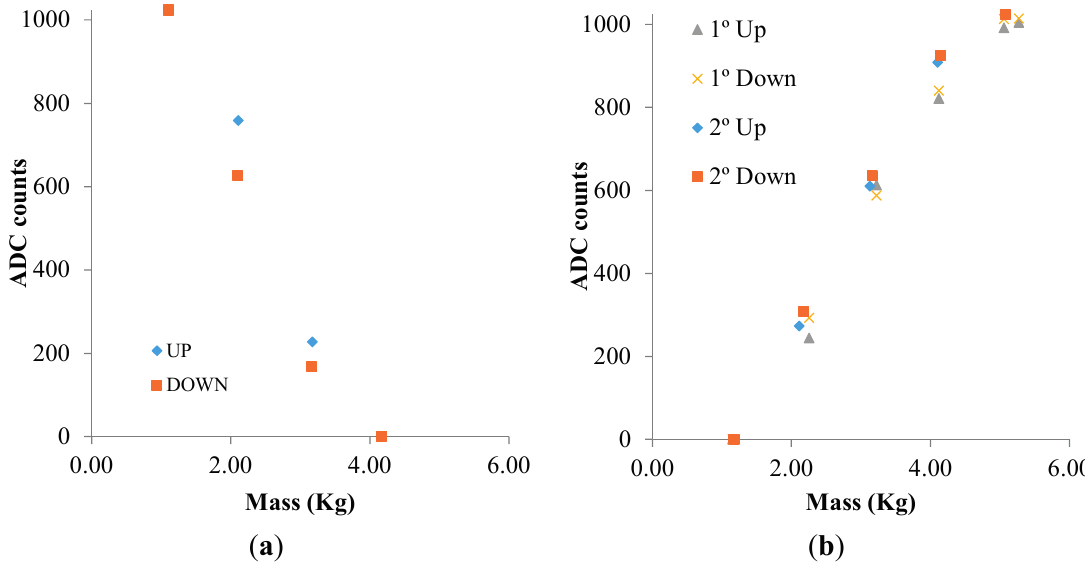
Figure 5. ADC counts for the force sensor measurements: ( a ) configuration as linear resistance; and ( b ) configuration as linear